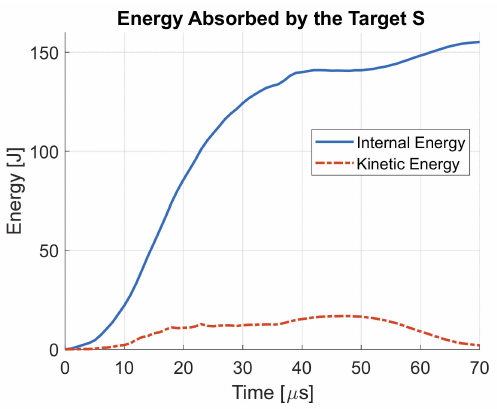
Figure 14. Energy absorbed by the target S at 820 m/s impact